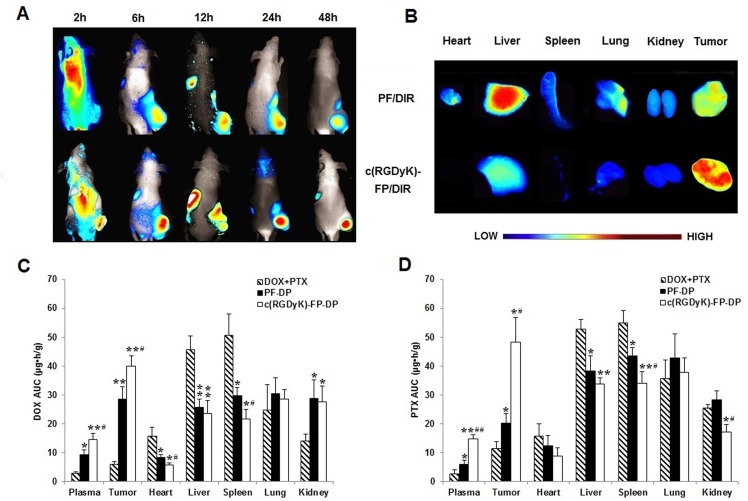
Biodistribution studies in tumor bearing mice.(A) In vivo fluorescence imaging of subcutaneous KBv tumor-bearing BALB/c nude mice after i.v. injection of PF/DIR and c(RGDyK)-FP/DIR at different time points; (B) Images of dissected organs of tumor bearing mice sacrificed at 48 h after i.v. injection of PF/DIR and c(RGDyK)-FP/DIR; The AUC0→48h of (C) DOX and (D) PTX in plasma and tissues after i.v. administration of the physical mixture of DOX and PTX (DOX+PTX), PF-DP and c(RGDyK)-FP-DP to subcutaneous KBv tumor-bearing BALB/c nude mice at a single 5 mg/kg dose of total drug, respectively. *P< 0.05, **P< 0.01, compared with DOX+PTX; #P< 0.05, ##P< 0.01, compared with PF-DP. Mean ± standard deviation (n = 3).